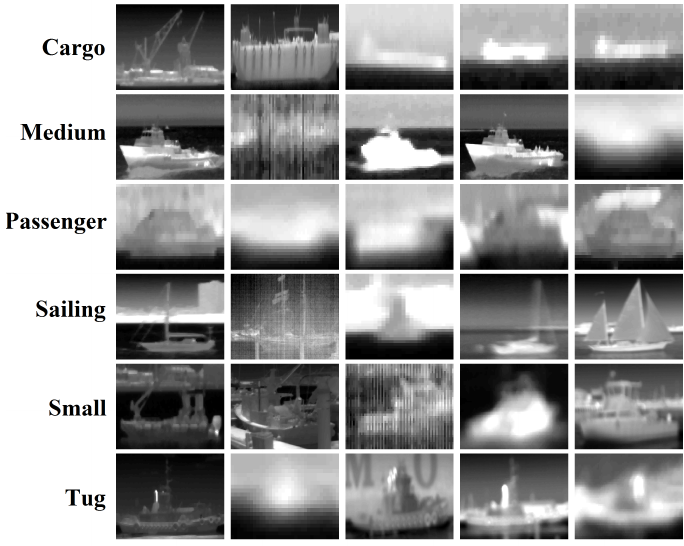
Figure 5. Some training examples of VAIS dataset, each row corresponds to the specified